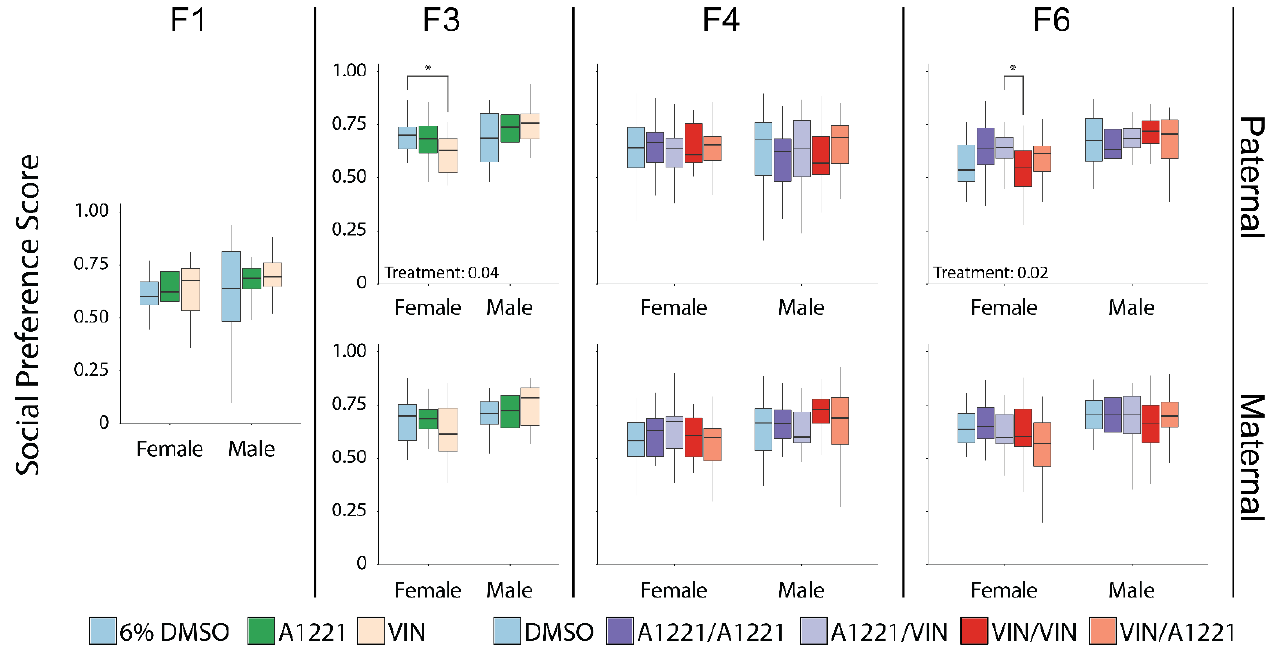
Figure 4. In the sociability test, the social preference score (time spent investigating the stimulus animal divided by the sum of the time spent investigating both the stimulus animal and an empty enclosure) for sociability is graphed as box and whisker plots (minimum, 25% quartile, median, 75% quartile, and maximum) shown separately by generation (F1 to F6 from left to right), lineage (paternal — top and maternal — bottom), and sex (indicated on x -axis). Lineage does not apply to the F1 generation. The social preference score was calculated as the time spent near the stimulus animal divided by the time spent near the stimulus animal plus the time spent near the empty enclosure. Scores above 0.5 indicate a preference for socializing with the stimulus animal. All group means were above the 0.5 threshold. Significant post hoc tests as determined by Tukey HSD are indicated with bars connecting the respective groups (* <0.05).